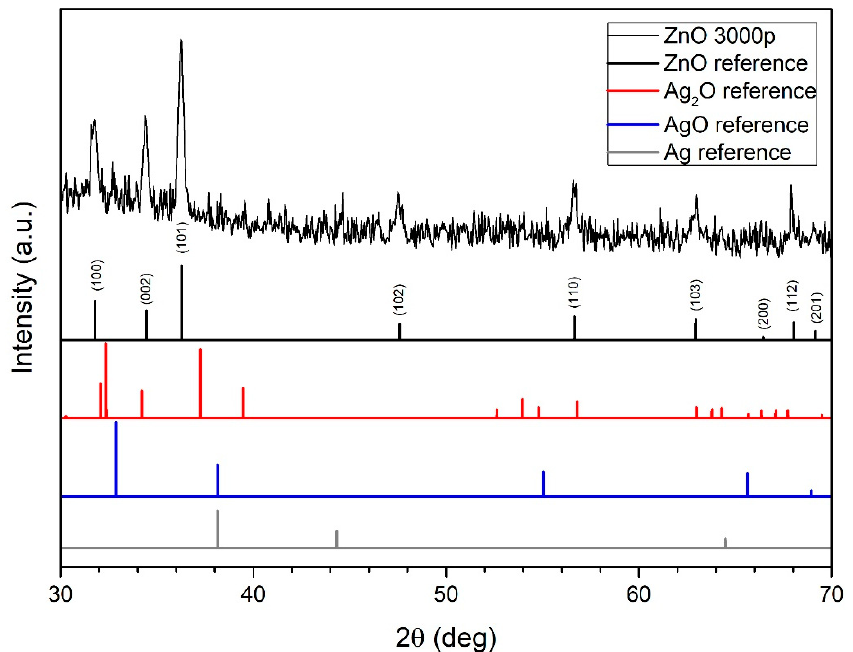
Figure 4 . XRD spectrum of ZnO NP (3000 pulses used for Ag deposition in PLD) and reference XRD spectral peaks of ZnO, Ag, AgO and Ag 2 O .